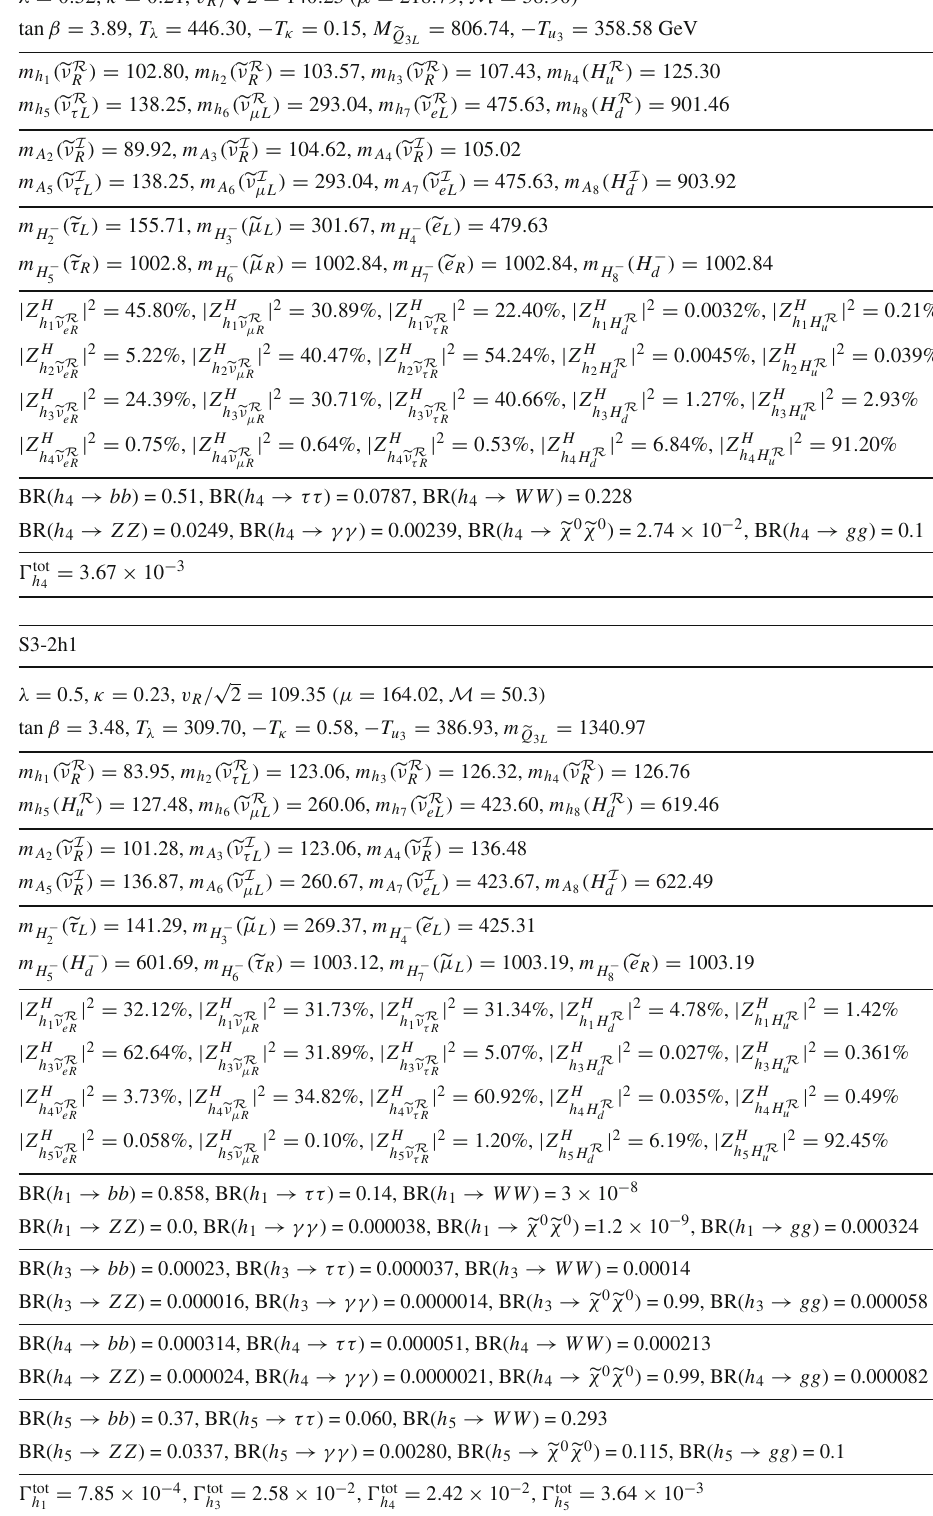
Table 13 The same as in Table. 12, but for a benchmark point S3-B1 with the SM-like Higgs h 4 not being the lightest scalar